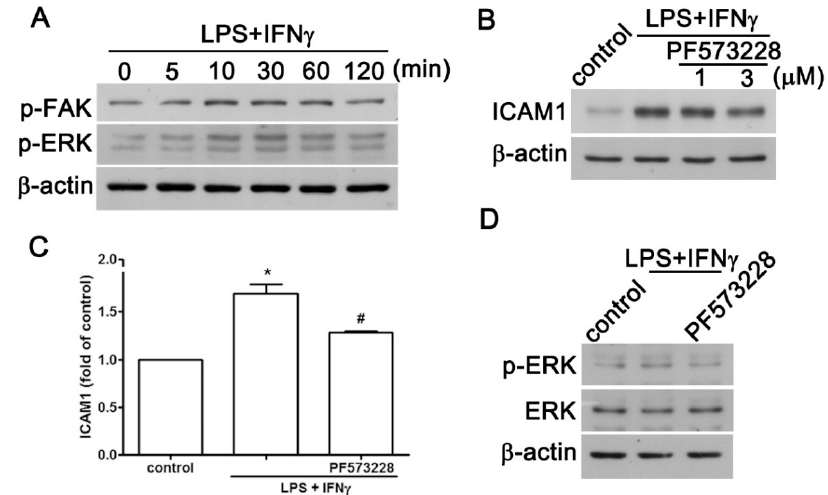
Figure 3. FAK/ERK is involved in the pro-inflammatory stimuli-associated expression of ICAM1 and CCL2 in human AF cells. ( A ) Cells were treated with LPS plus IFN γ for 5, 10, 30, 60, or 120 min, and expression of phosphorylated FAK1 and phosphorylated ERK were determined using western blot analysis. ( B ) Cells were treated with the FAK inhibitor PF573228 (1 or 3 μ M) for 30 min and stimulated with LPS plus IFN γ for another 24 h. ICAM1 expression was determined using western blot analysis. Cells were treated with PF573228 (1 μ M) for 30 min and treated with LPS plus IFN γ for another 6 h, and examined for cell surface ICAM1 ( C ) and CCL2 ( D ). Cells were treated with PF573228 (1 μ M) for 30 min and stimulated with LPS plus IFN γ for another 60 min, and phosphorylated ERK expression was determined using western blot analysis. Quantitative data are presented as the mean ± SEM (representative of n = 3). * p < 0.05 compared with the control group. # p < 0.05 compared with the LPS/IFN γ treatment group.